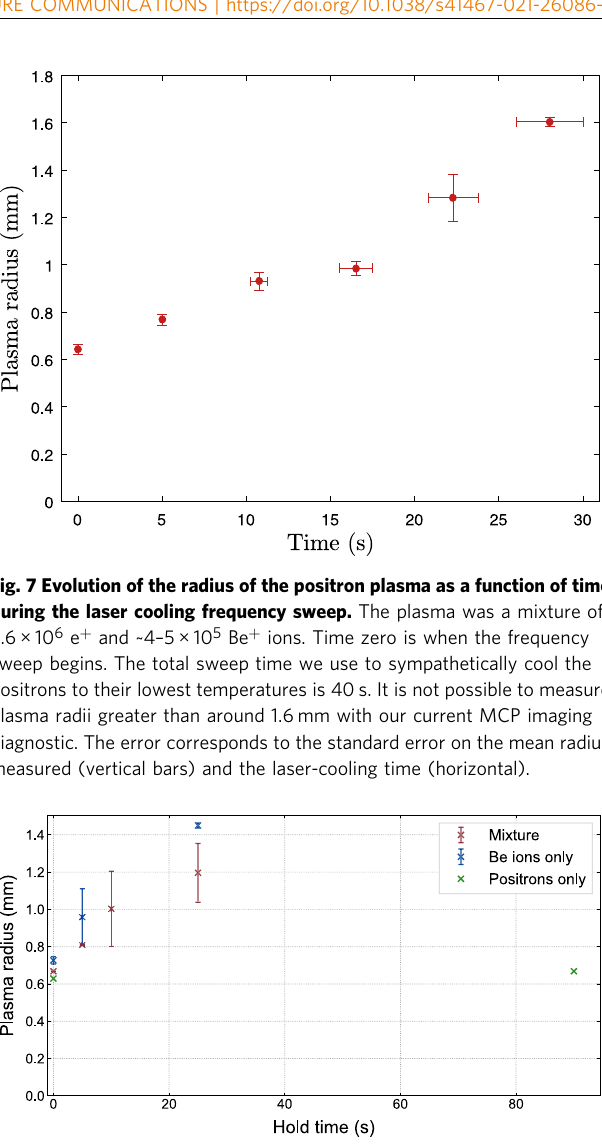
Fig. 8 Evolution of the radius of three different plasmas as a function of time without laser-cooling in a 1 T fi eld. The mixture (red) consists of 2.6 × 10 6 e + and 4 × 10 5 Be + . The Be + only plasmas contained 4 × 10 5 Be + . The positrons only plasma contained 2.6 × 10 6 e + . The vertical error bars correspond to the standard error on the mean radius measured at each hold time.